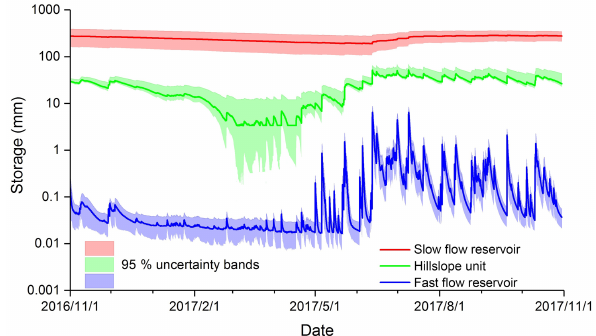
Figure 8. Model-derived storage dynamics in hillslope ( V h ) and slow ( V s ) and fast ( V f ) conceptual reservoirs for the best 500 pa- rameter sets, and the lines represent the mean of